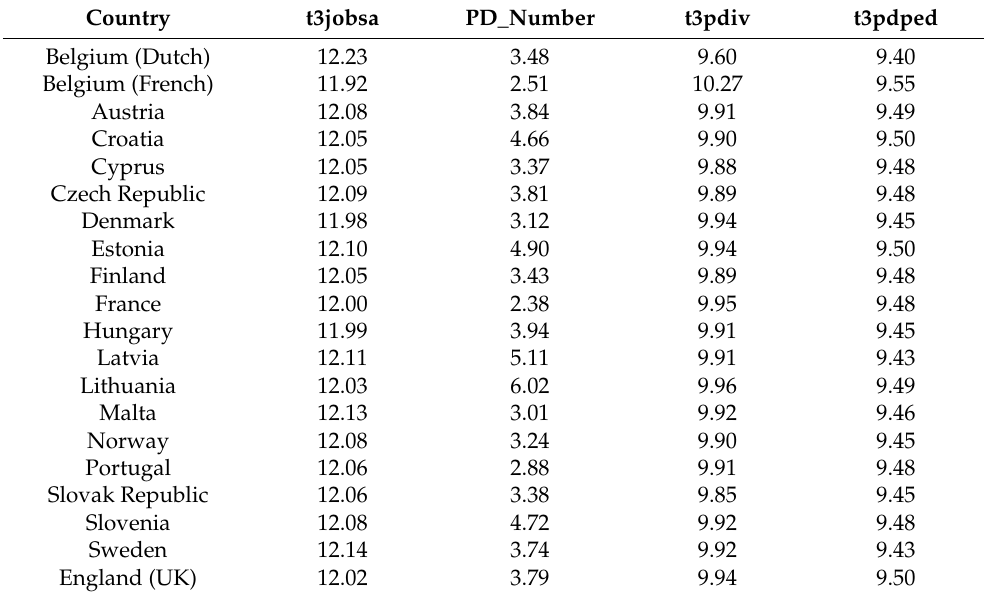
Table 2. Job satisfaction and professional development across regions (mean values per